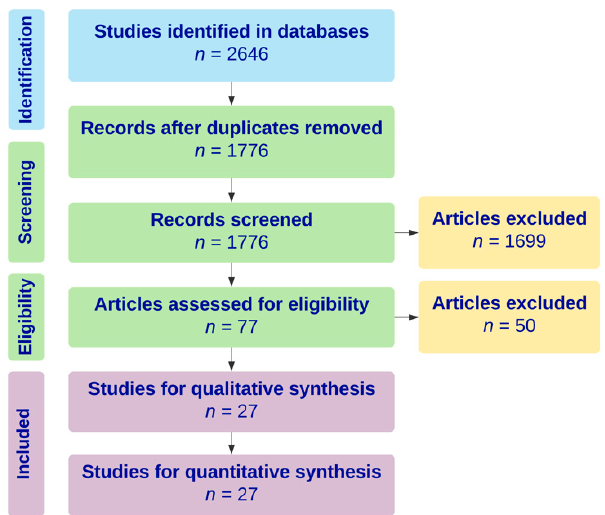
Figure 1. Preferred Reporting Items for Systematic Reviews and Meta-Analysis (PRISMA) diagram outlining literature search strategy for systematic review.